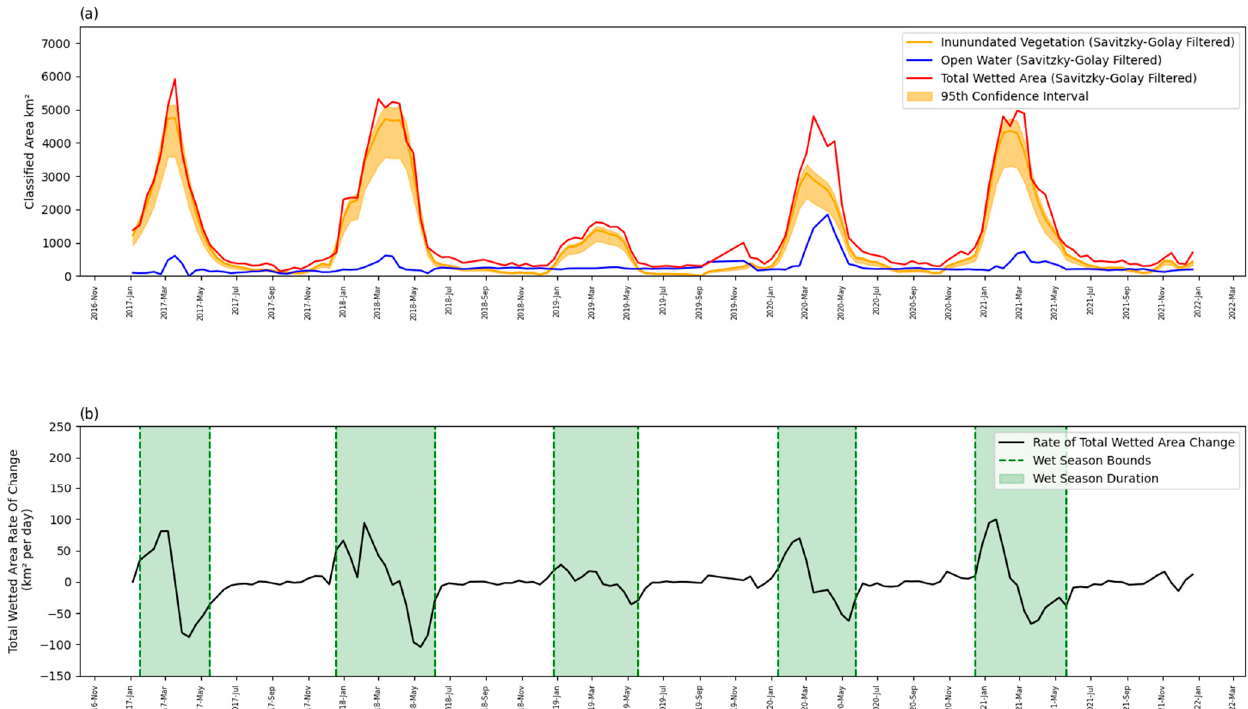
Figure 14. ( a ) RadWet detected total wetted area, inundated vegetation, and open water extent between Jan 2017 to December 2021 (142 observations) for the Barotseland Floodplain, Zambia. ( b ) Rate of change derivative of the total wetted area, with wet season timings indicated.